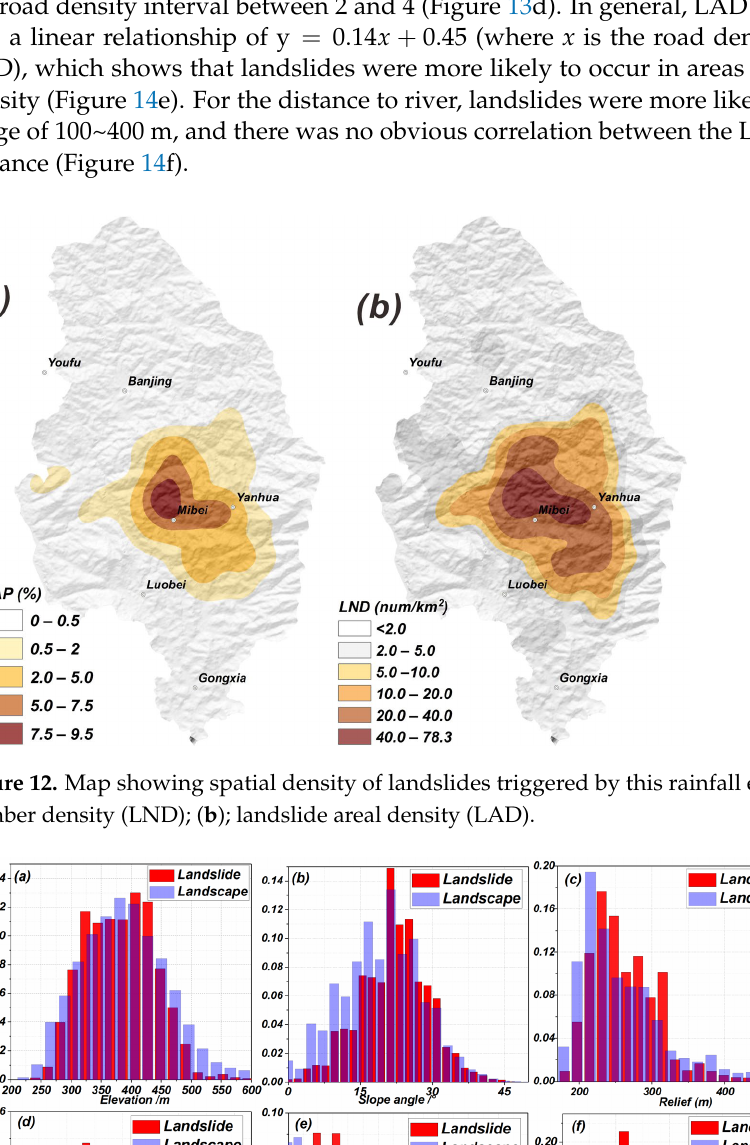
Figure 12. Map showing spatial density of landslides triggered by this rainfall event. ( a ) landslide number density (LND); ( b ) ;andslide areal density (LAD).